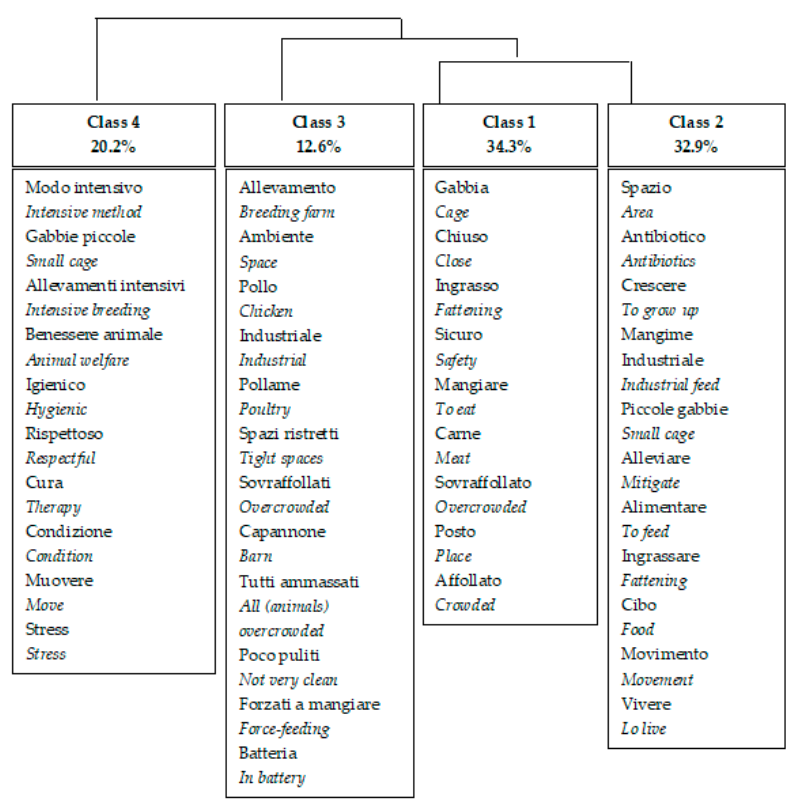
Figure A1. The word translation of the 4 clusters as reported in Figure 5.